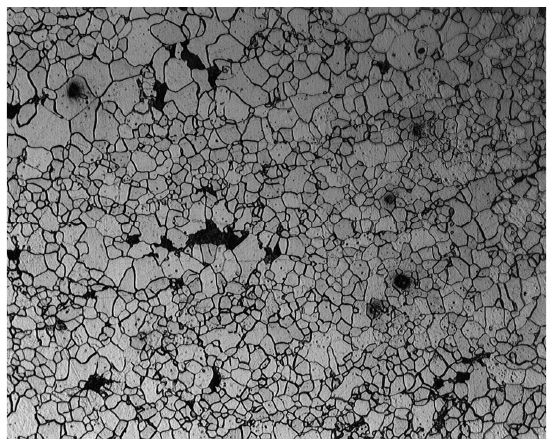
Figure 1. As-received microstructure of the low-carbon microalloyed